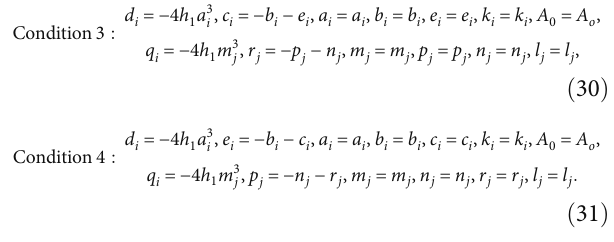
Figure 4: The parameters of μ a 3 = b 3 = m 2 = 3, A 0 = z = t = s = 0 . (a) Three-dimensional map. (b) Contour